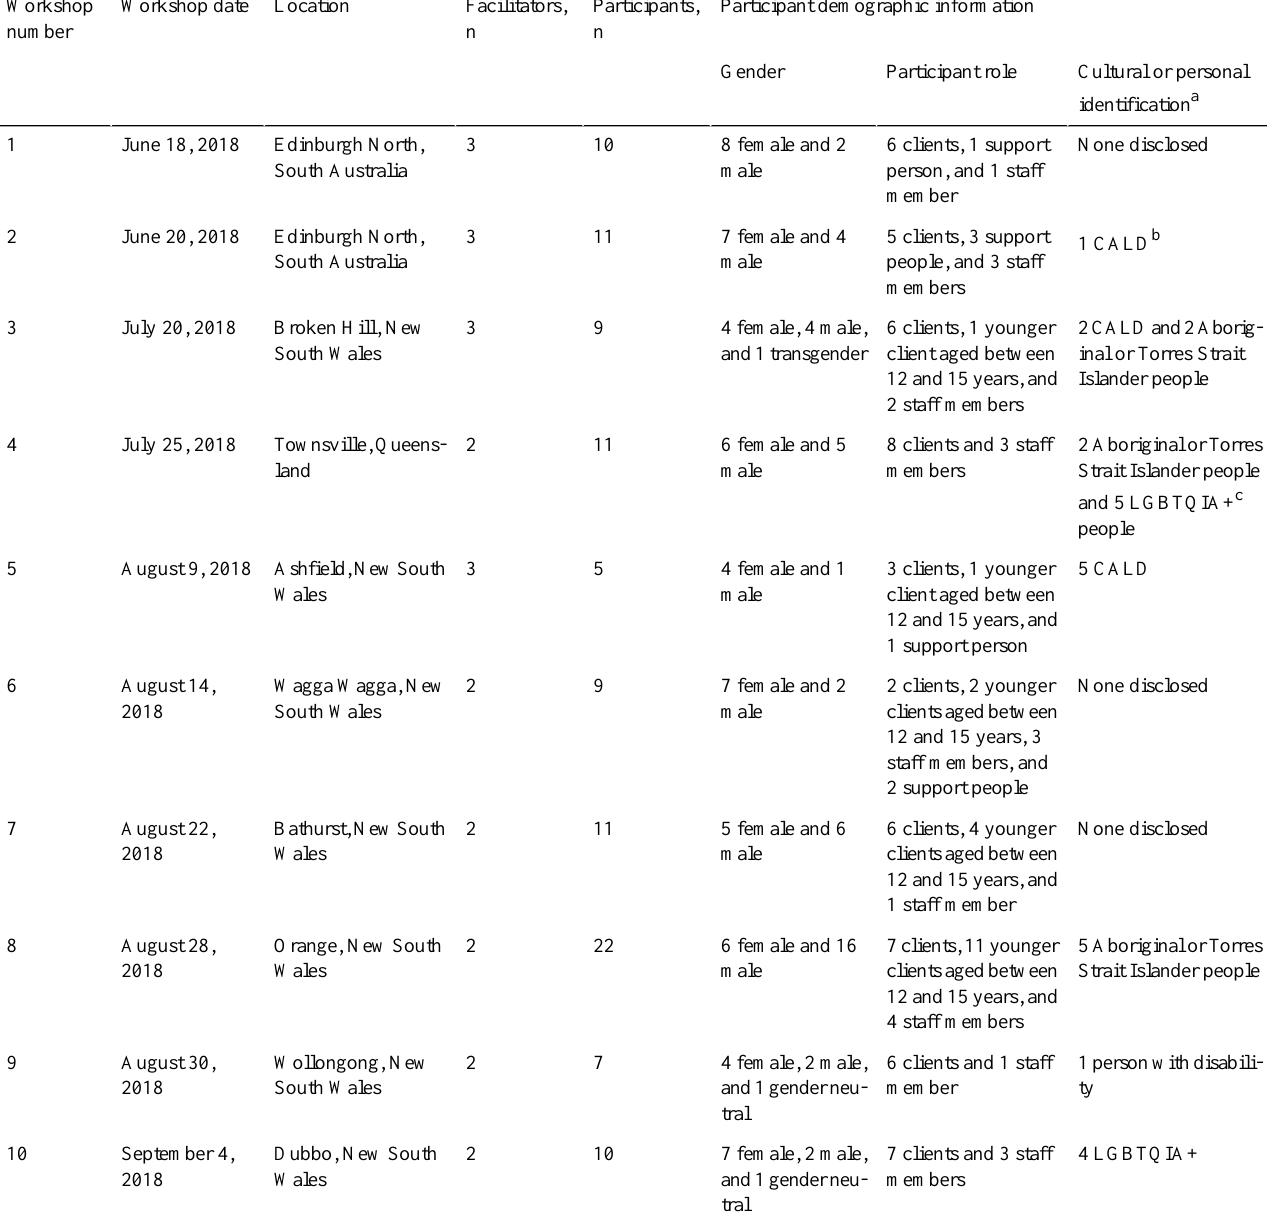
Table 2. Workshop and participant details